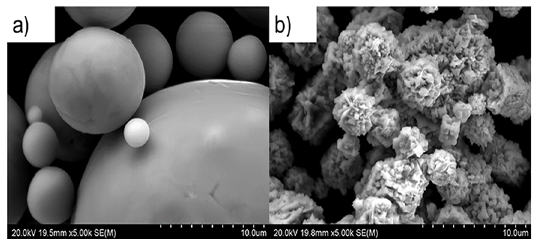
Figure 1. Schematic of a pore tunnel. Pore geometry can be divided into two regions of pore-mouth and pore-throat Figure 2. Morphologies of the starting powders. a) Ti b)